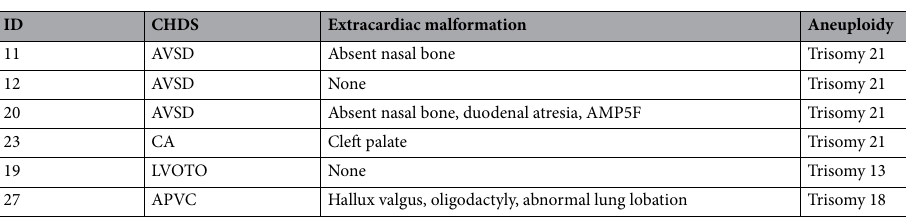
Table 2. Aneuploidies in the cohort. AMP5F abnormality of the middle phalanx of the 5th finger, APVC anomalous pulmonary venous connection, AVSD atrioventricular septal defect, CA conotruncal anomalies, CHDS congenital heart defect subtype, LVOTO left ventricular outflow tract